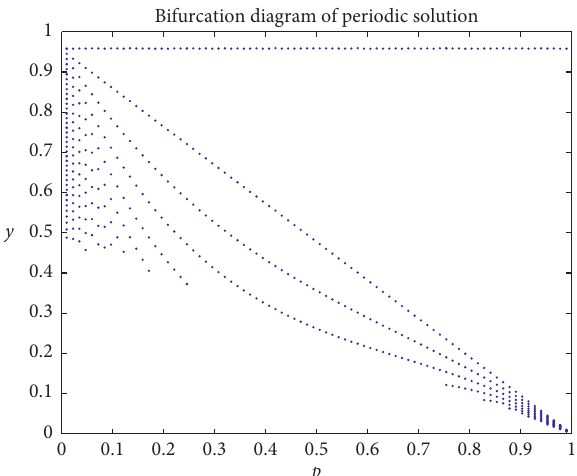
Figure 15: Bifurcation diagram of system (12) with respect to p for p ∈ (0,